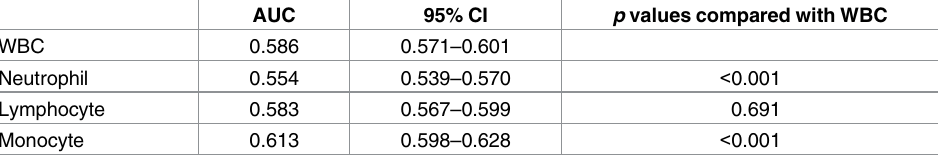
Table 4. Receiveroperating characteristics (ROC) curve analysesof each WBC subtypes for cardio- vasculardisease.